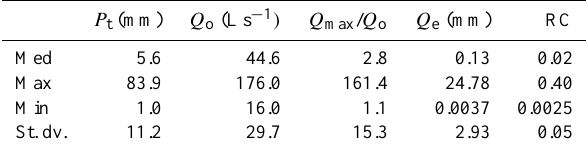
Table 3. Median, maximum, minimum and standard deviation of total precipitation ( P t ), initial discharge ( Q o ), relationship between maximum discharge and initial discharge ( Q max / Q o ), event runoff ( Q e ) and runoff coefficient (RC) for the 222 rainfall events recorded between 2003 and 2008.